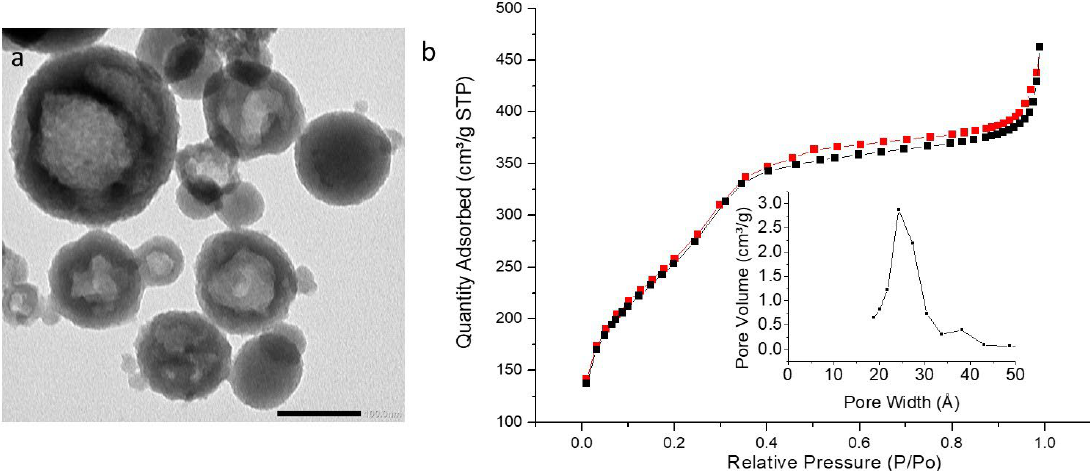
Figure 9. ( a ) TEM image of iPrbiPyPMO 10 scale bar 100 nm. ( b ) Nitrogen adsorption–desorption at 77 K. Insert BJH desorption (dV/dlog(w)) Pore Volume.